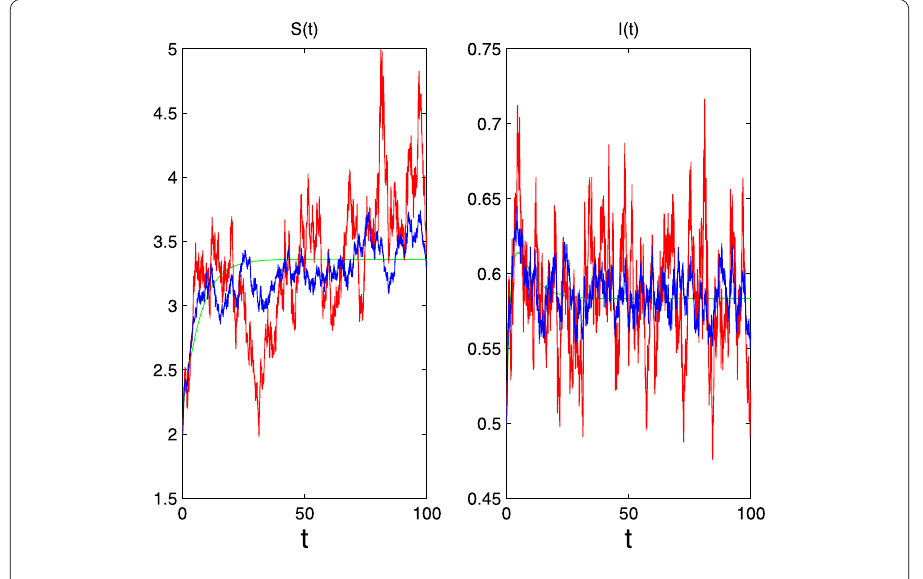
Figure 1 The populations are persistent in the mean for system